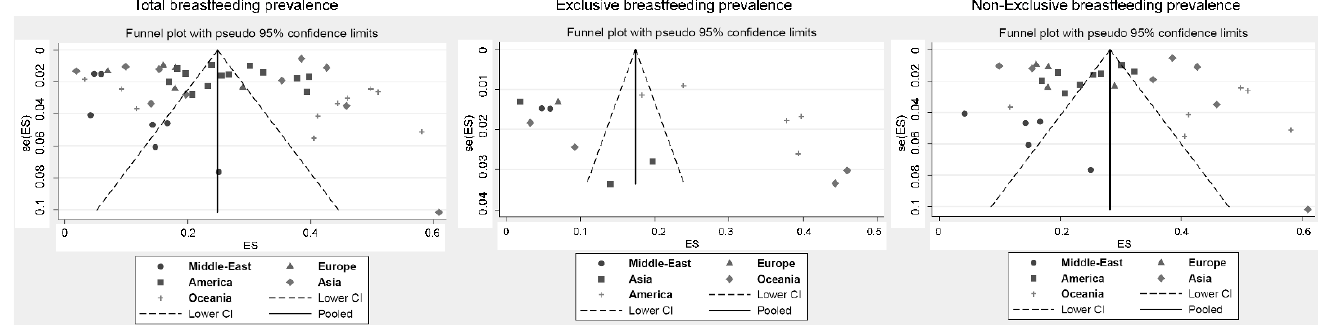
Figure 4. Meta-regression. 4. Discussion The main finding was that the prevalence of breastfeeding after RTW is widely het- erogeneous across the world. Despite the review demonstrating that economic status may